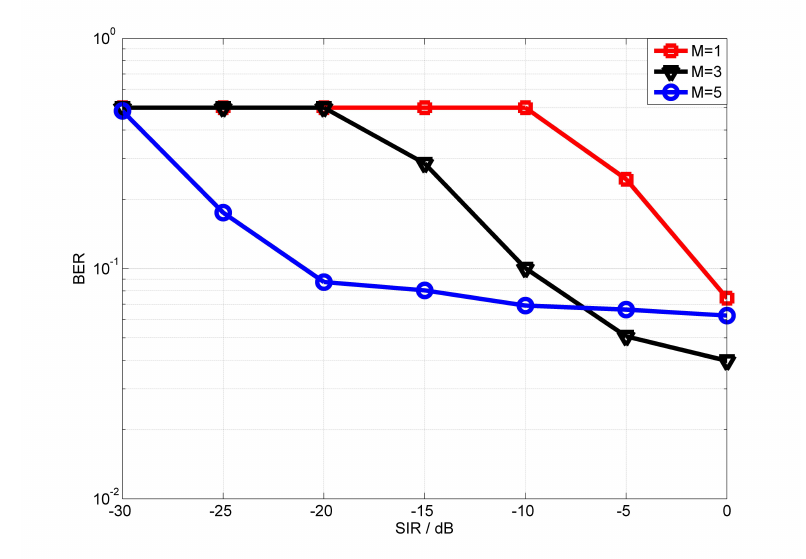
Figure 13. The BER performance of